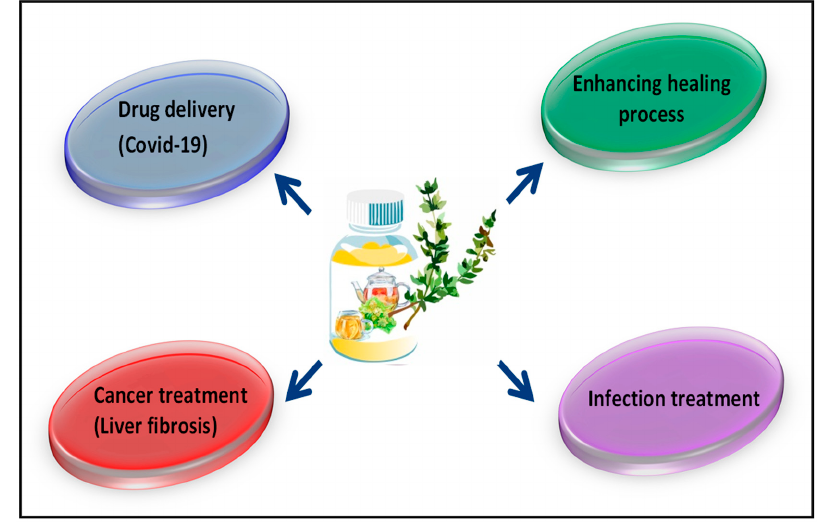
Figure 5. The future trend of herbal materials.